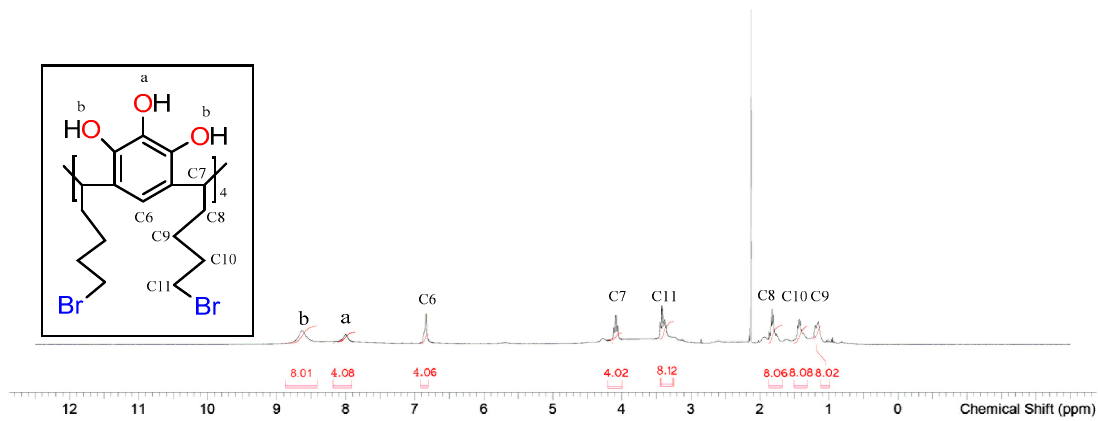
Figure 1. 1 H NMR spectrum (400 MHz, d 6 -DMSO, room temperature) of C -bromobutylpyrogallol[4]arene 2 .